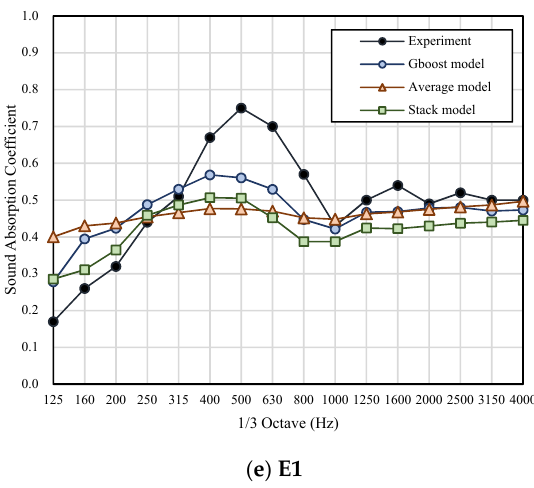
Figure A2. Prediction Results of the ML Model.